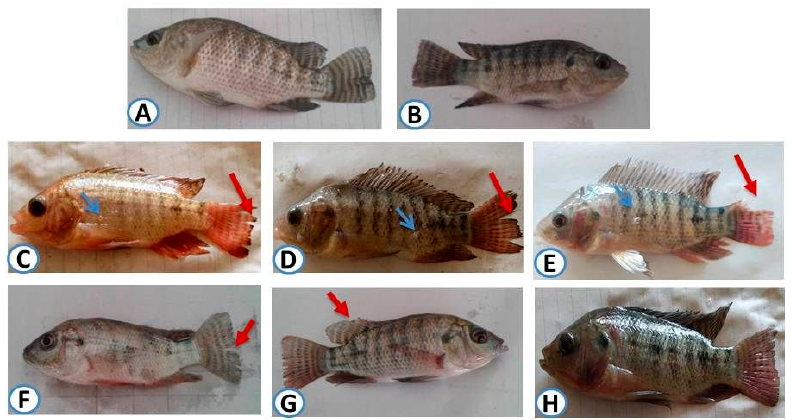
Figure 1. Clinical signs of O. niloticus that were exposed to LCT and/or MTM (1/20 of LC50) and fed on diets containing 1% taurine (TUR) for 60 days. ( A , B ) Fish that were fed on the basal diet, without or with TUR supplementation, showed normal appearance. ( C – E ) Fish that were fed on a basal diet only and exposed to LCT ( C ) or MTM ( D ) or both ( E ) showed severe fin rot (red arrow), increased mucus secretion (light blue arrow), erythema, and hemorrhages on different body parts. ( F – H ) Fish that were fed on a basal diet containing TUR and exposed to LCT ( F ) or MTM ( G ) or both ( H ) showed a normal appearance except slight fin rot (red arrow).